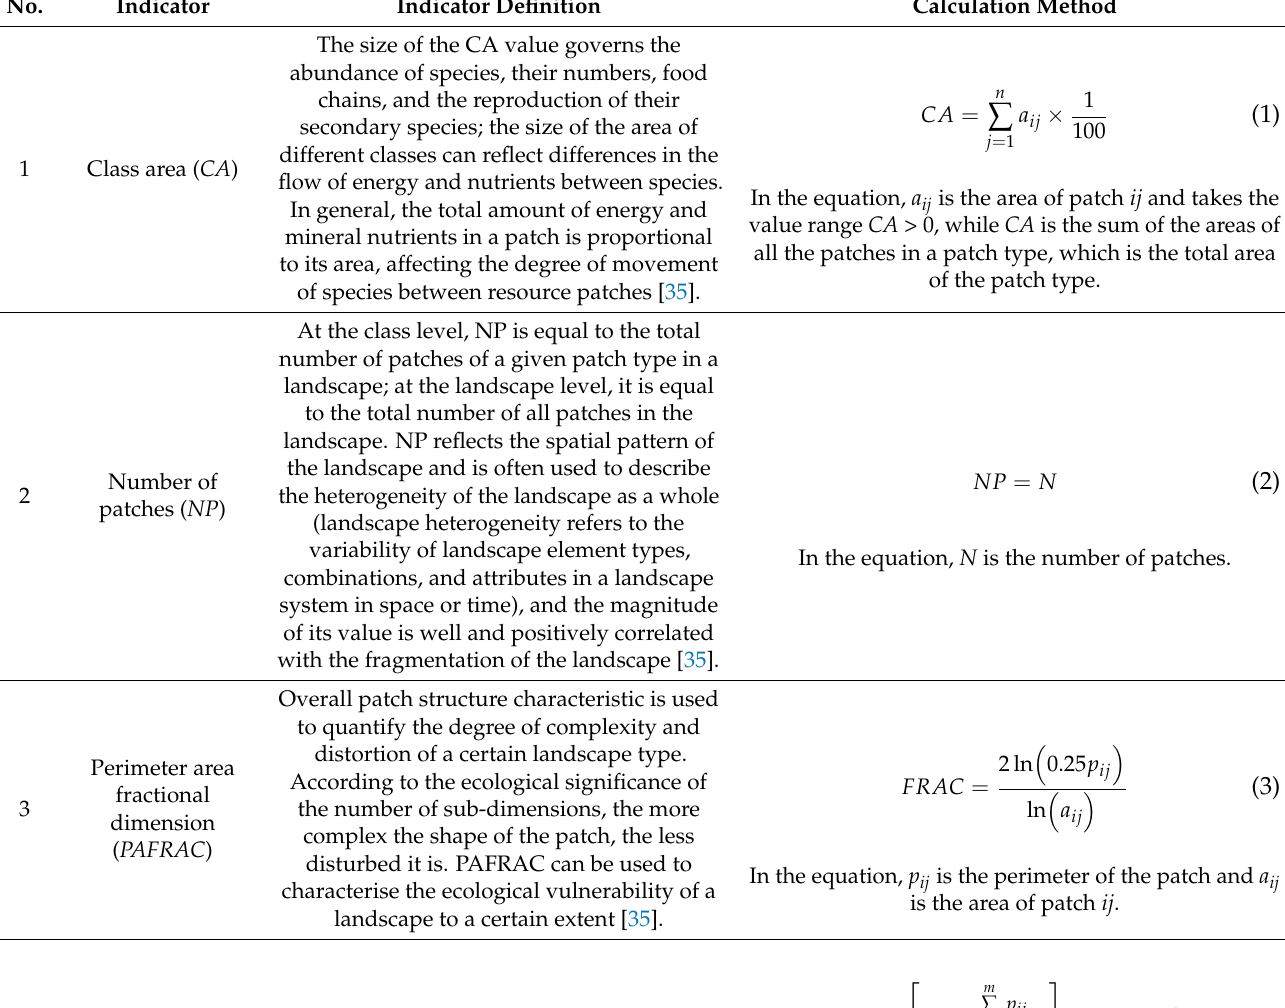
Table 1. List of research methods, calculation results, and standardised values for the Three Parallel Rivers Natural World Heritage